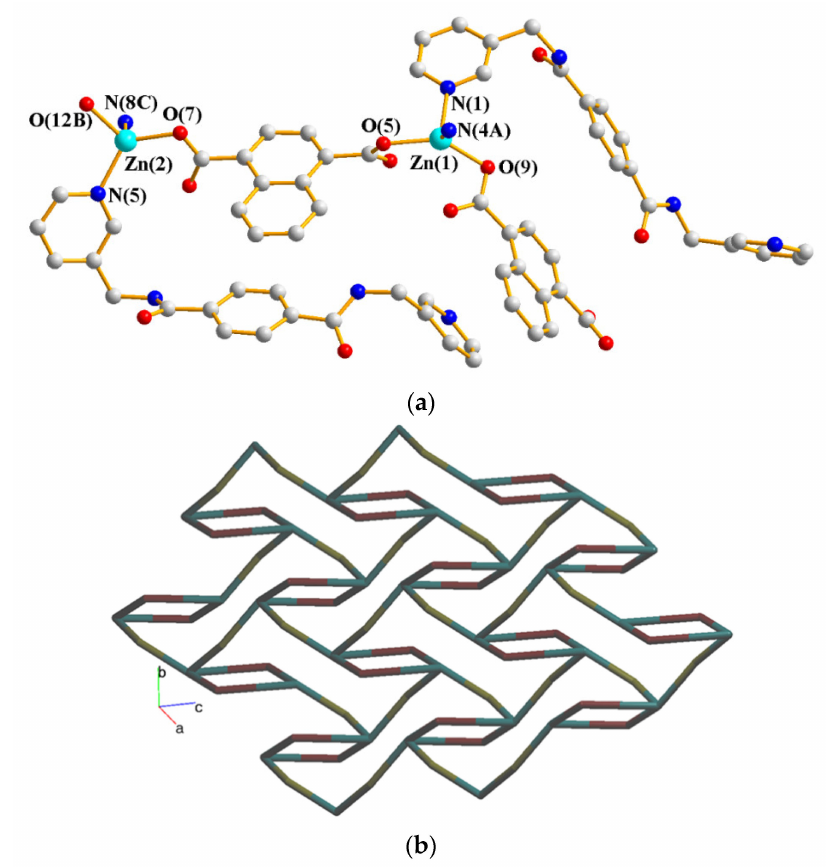
Figure 9. ( a ) The coordination environment of the Co(II) ion in 8 . Symmetry transformations used to generate equivalent atoms: (A) − x, − y + 2, − z + 2; (B) x, y, z – 1; (C) − x, − y + 1, − z + 1. ( b ) A drawing showing the (10 2 · 12)(10) 2 (4 · 10 · 12 4 )(4)